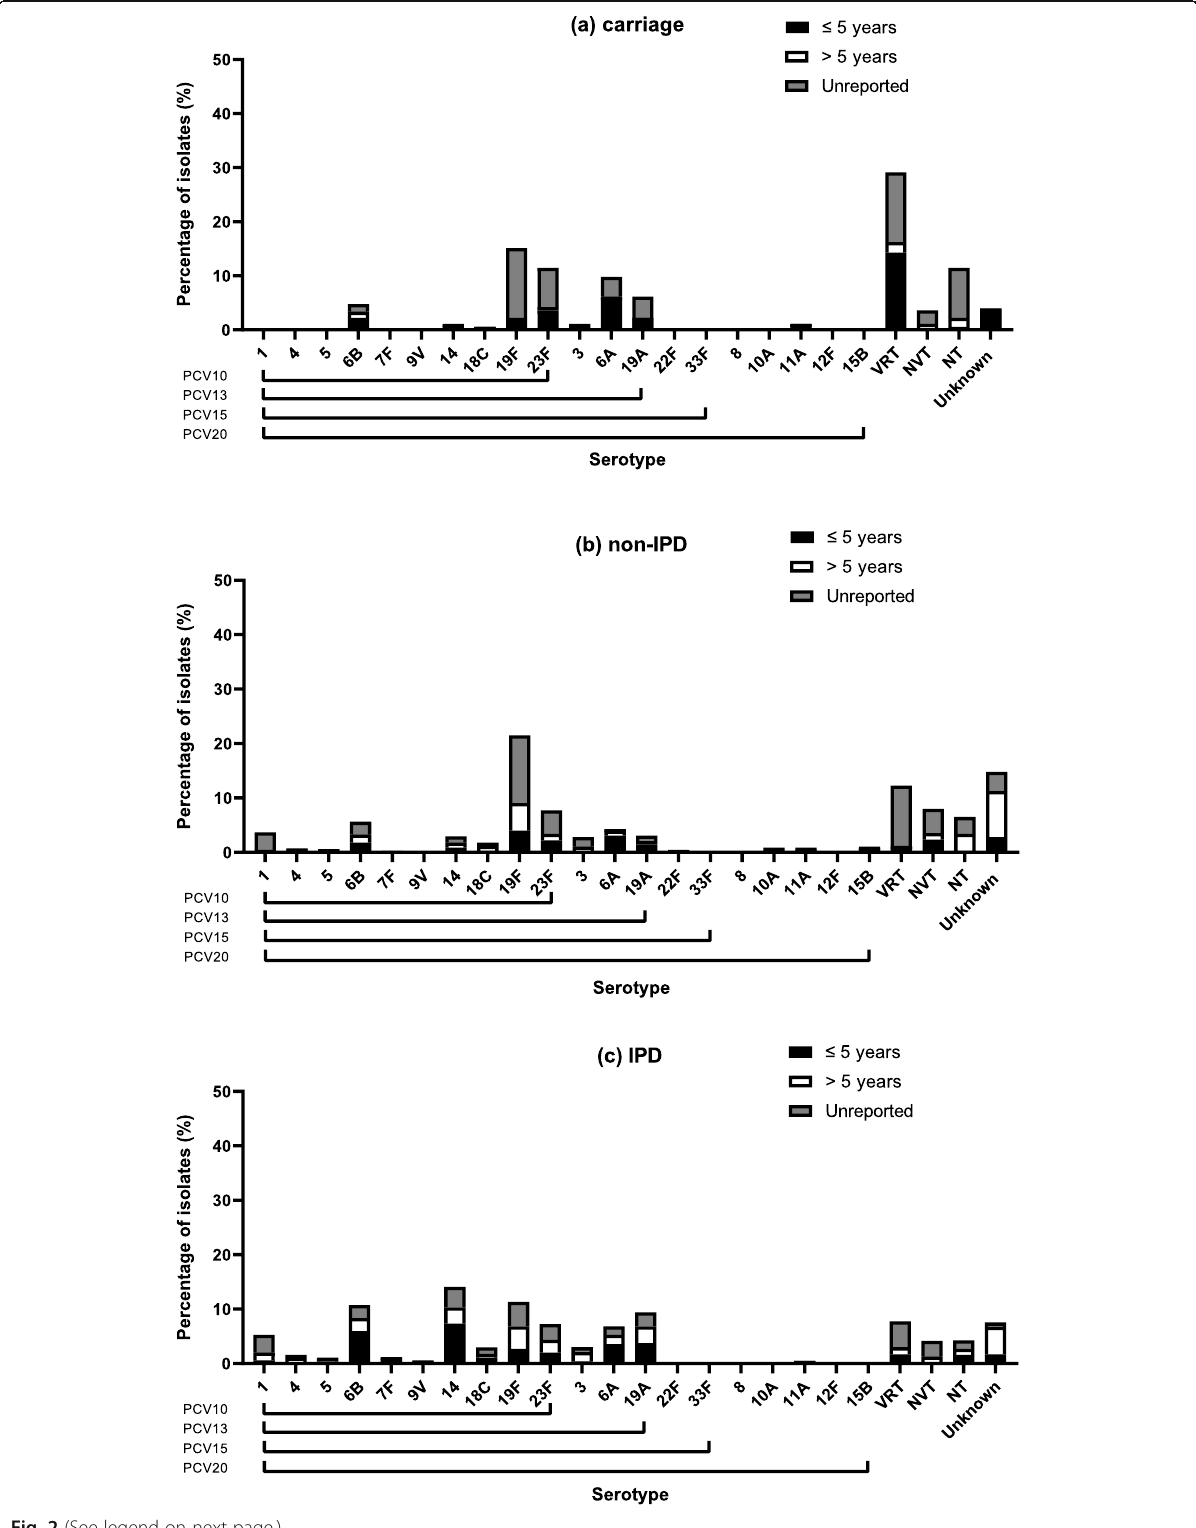
Fig. 2 (See legend on next